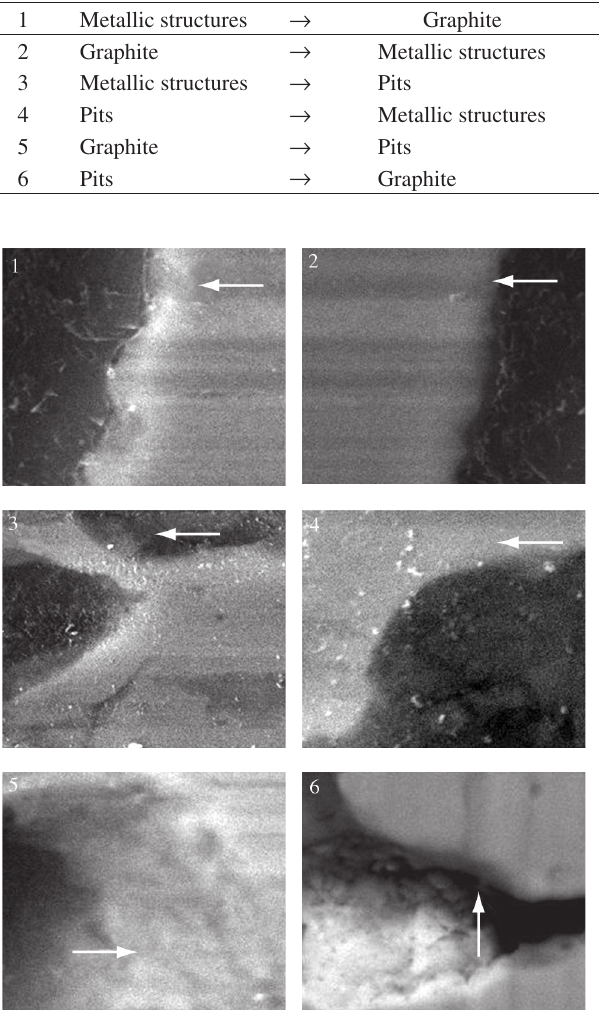
Figure 4. Borders between zones of the brake disc operating surface; arrows correspond to the direction of sliding speed.